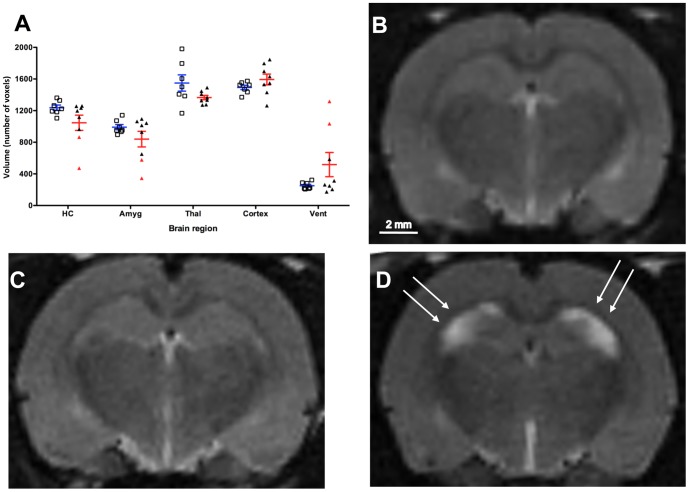
Volumes of regions of interest for epileptic and control animals as measured by manual delineation on MRI.(A) Results are expressed as volumes (number of voxels, median and inter-quartile range) in control (blue lines, n = 7) and epileptic animals (red lines, n = 8). Individual volumes are plotted for control (open squares) and epileptic animals (closed triangles). A subset of epileptic animals showed reduced hippocampal and amygdala volumes and increased ventricular volume (red triangles, n = 2) indicative of hippocampal sclerosis. Coronal slices through the hippocampi on MRI (B) a control animal, (C) an epileptic animal without hippocampal sclerosis, (D) an epileptic animal with hippocampal sclerosis. White arrows indicate decreased hippocampal volume.